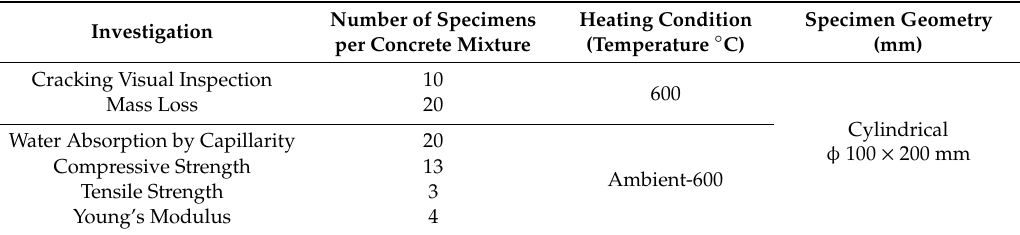
Table 3. Summary of investigation tests.